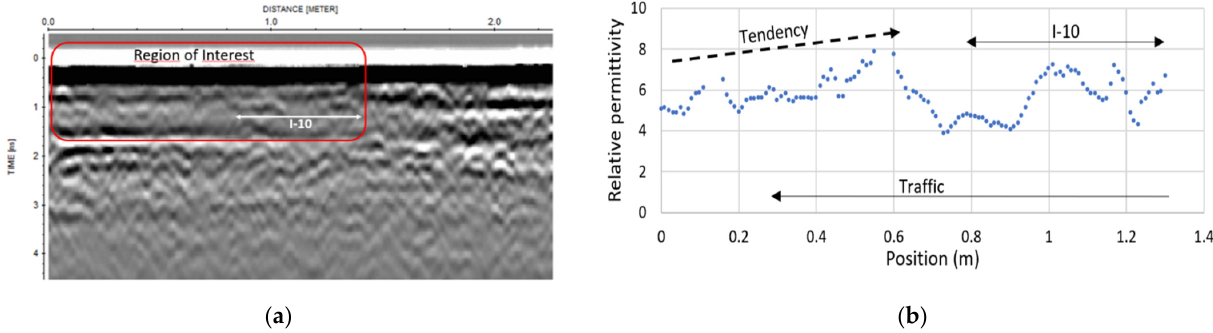
Figure 42. ( a ) 2.6-GHz transversal profile done on defect I-10 at 800 K loadings. ( b ) Estimation of the relative permittivity of the asphalt layer 1.